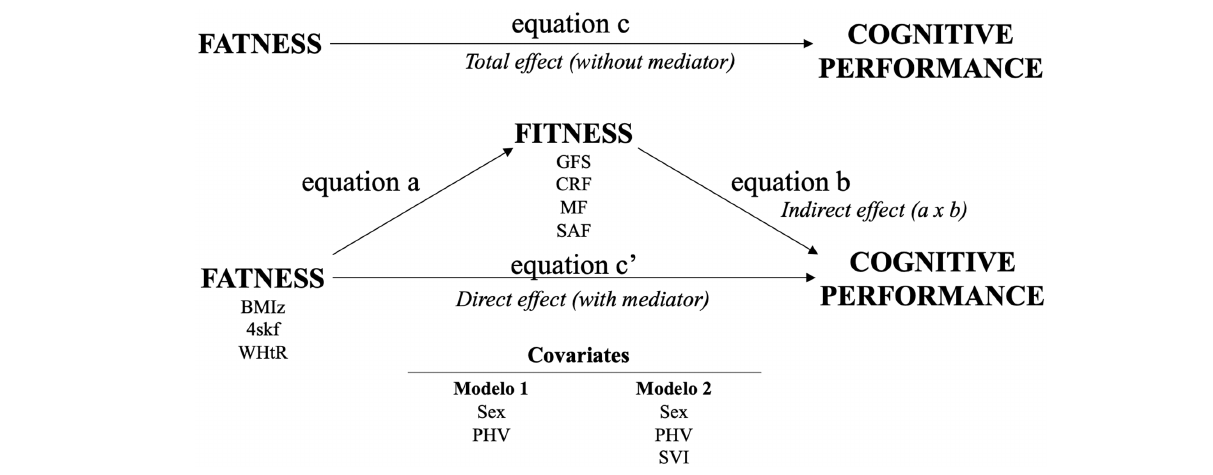
FIGURE 1 | Theoretical approach and general mediation model. BMIz, body mass index (zscore); 4SKF, sum-of-4-skinfolds; WHtR, waist-to-height ratio; GFS, global fitness score; CRF, cardiorespiratory fitness; MF, muscular fitness; SAF, speed-agility fitness; PHV, peak high velocity; SVI, school vulnerability